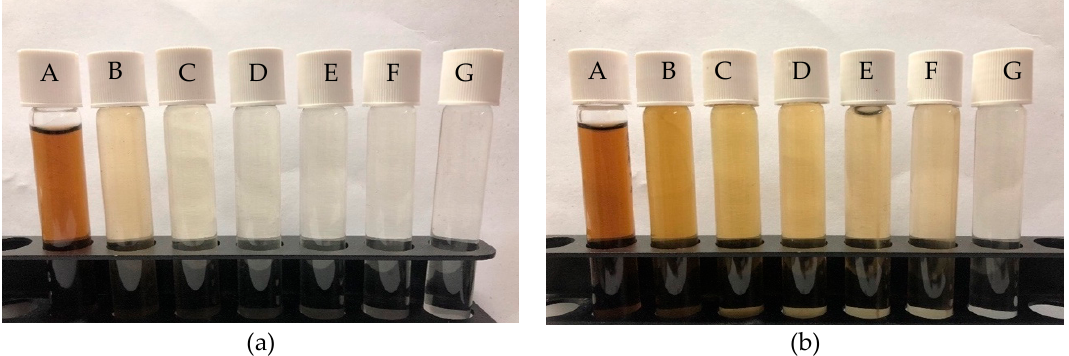
Figure 6. Pictorial view of color removal at 5 h of POMB-retained ash: ( a ) microwave irradiated and ( b ) H 2 SO 4 – microwave irradiated at various pHs (A = control, B = pH 8.5, C = pH 6, D = pH 5, E = pH 4, F = pH 3, and G = pH 2).